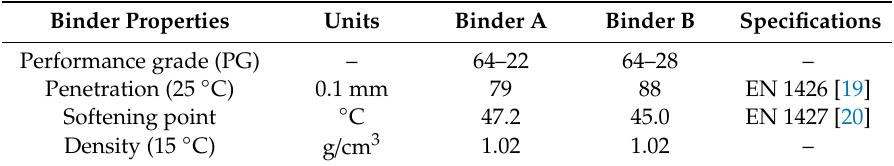
Table 1. Characteristics of the unmodified asphalt